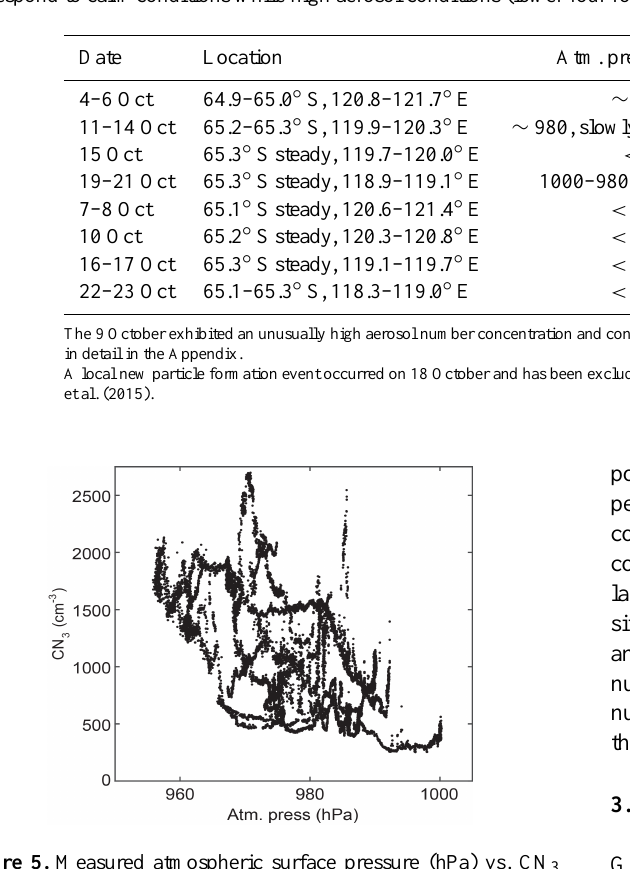
Table 1. Summary of meteorological parameters and corresponding CN 3 number concentrations. Low aerosol concentrations (top four rows) correspond to calm conditions while high aerosol conditions (lower four rows) correspond to parameters that suggest cyclone activity.